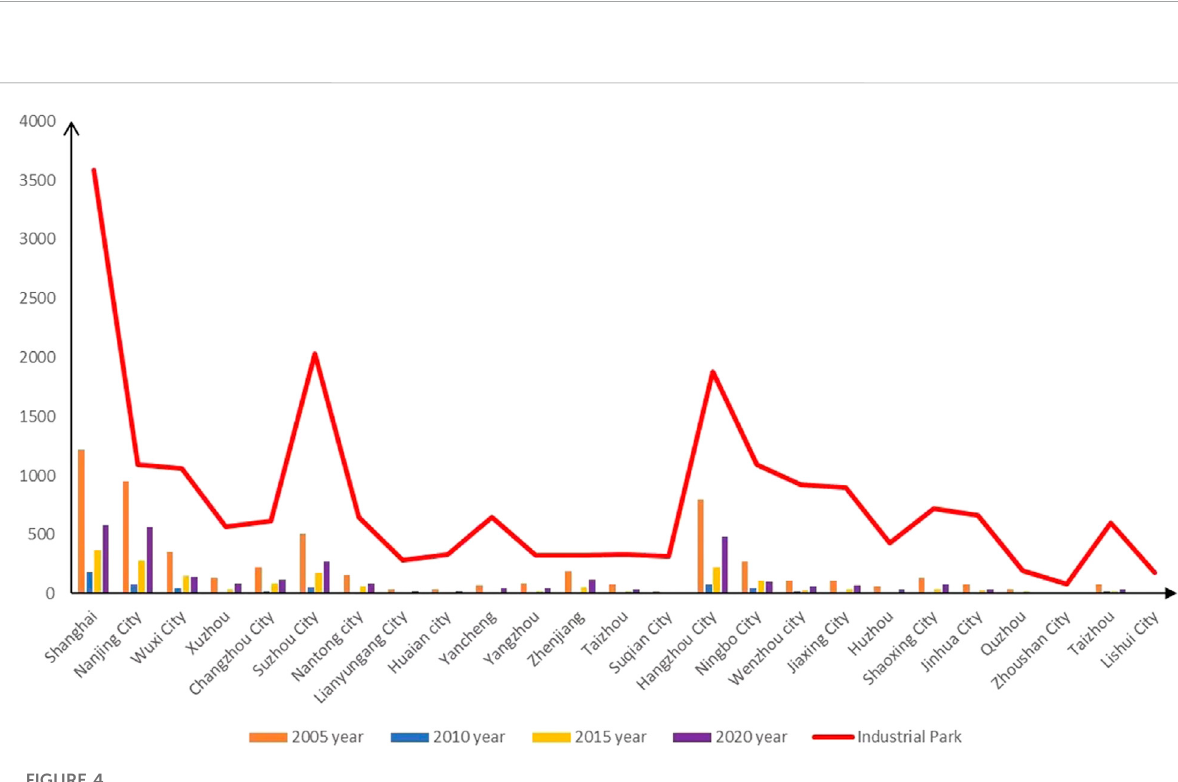
FIGURE 4 Relationship between CHP technology innovation and agglomeration of high-tech industrial